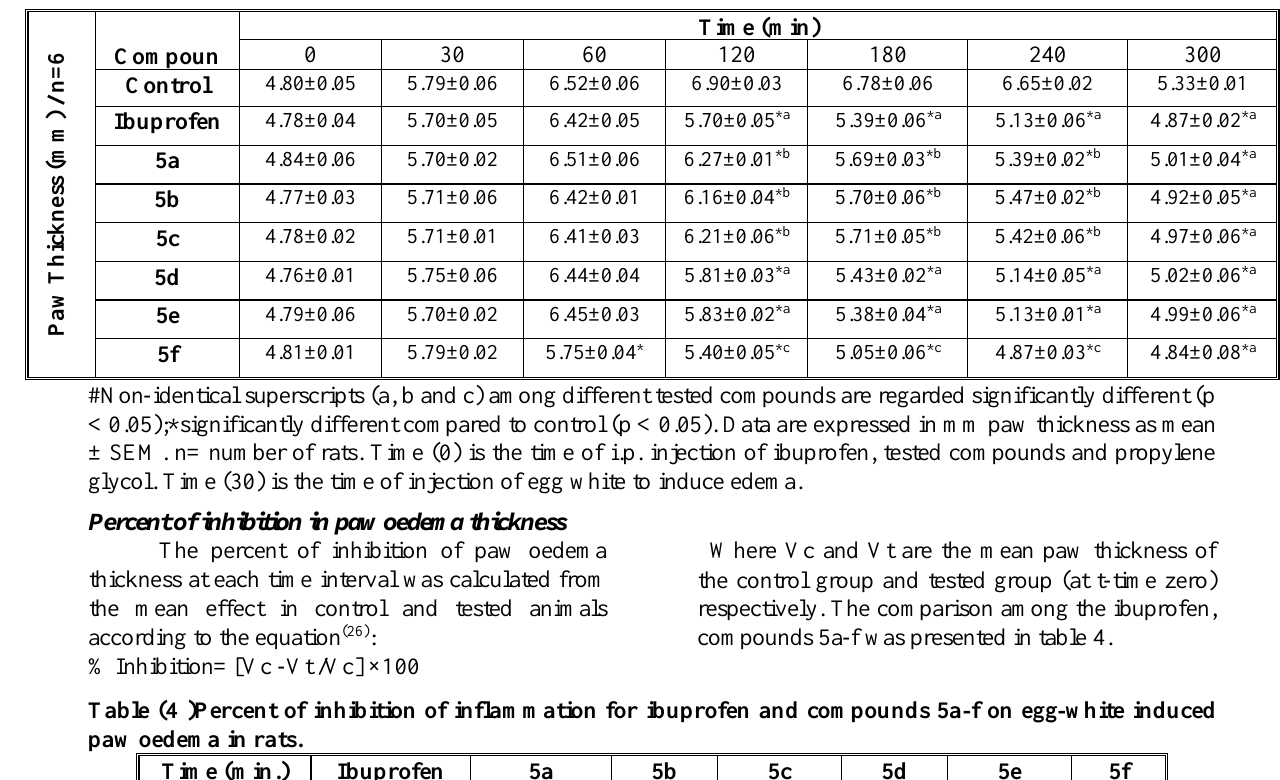
Table( 3 )The anti ‐ inflammatory effect of control, ibuprofen and compounds 5a ‐ f on egg ‐ white induced paw edema in rat #